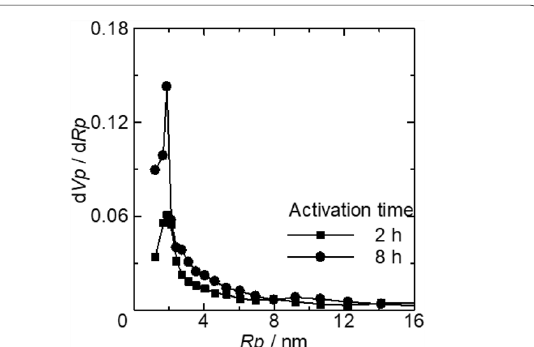
Fig. 2 Adsorption isotherms of 2-h-activated tunicate cellulose (TC) carbon and 8-h-activated TC carbon. The open and closed symbols indicate the desorption and adsorption curves, respectively. V /mL (STP) g − 1 indicates the absorption amount per 1 g of sample. P / P 0 is relative pressure